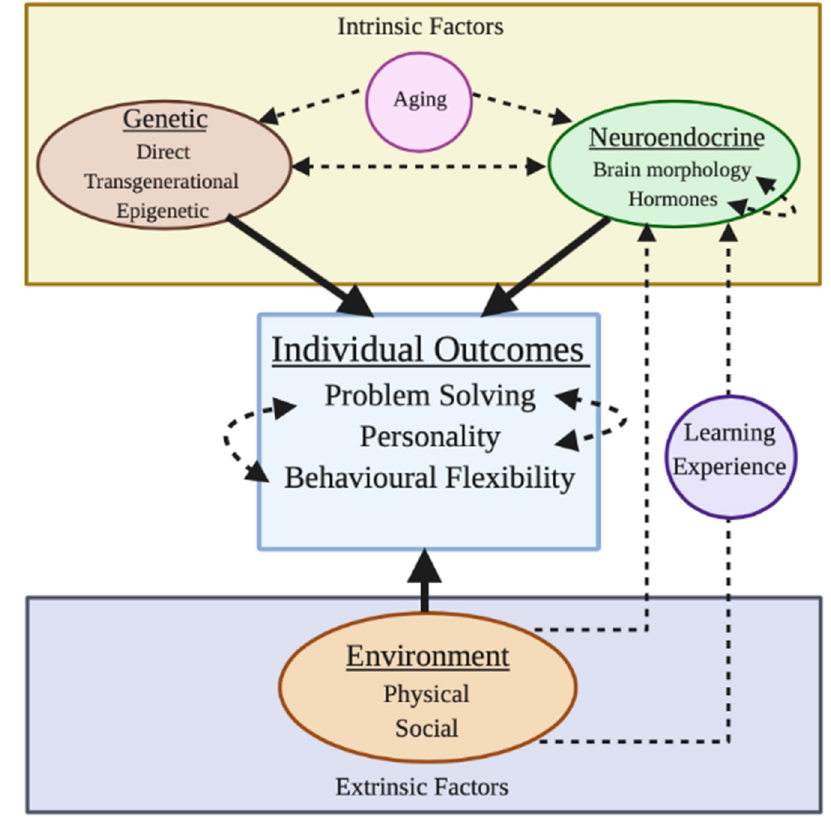
Figure 1. Intrinsic (genetic, neuroendocrine, and aging), extrinsic (environment) and acquired (learning and experience) factors influencing an individual’s development directly (solid arrows) or indirectly (dashed arrows). Arrow heads indicate direction of influence.